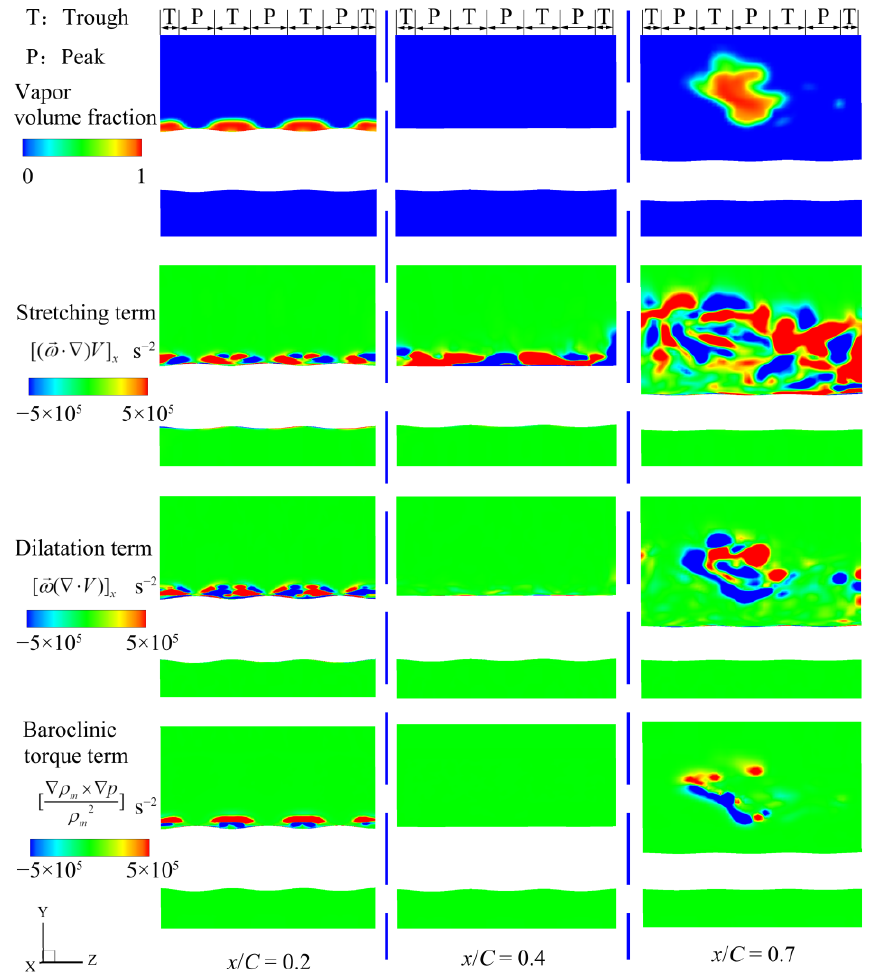
Figure 13. Predicted vapor volume fraction, vortex stretching term, vortex dilatation term and baroclinic torque term of the modified hydrofoil at different YZ planes.